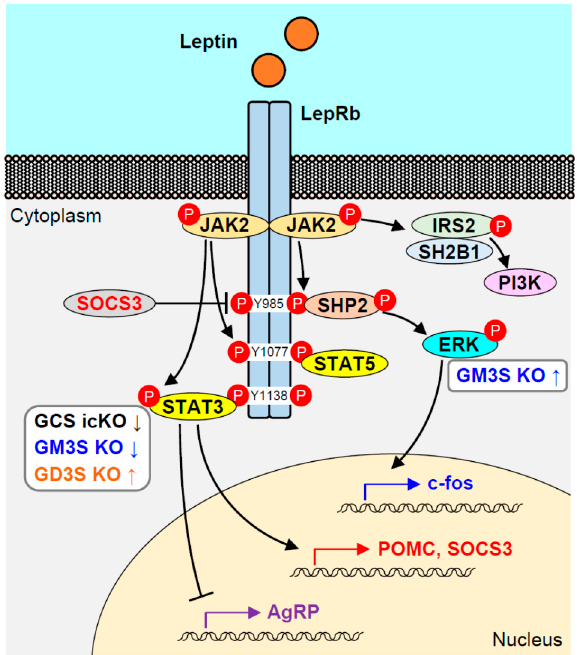
Figure 2. Leptin receptor signaling pathway, and alterations in signaling that characterize various ganglioside-deficient KO mouse models. Up and down arrows indicate increased or decreased activation of STAT3 or ERK in the pathways for the models. GCS icKO: tamoxifen-inducible, neuron-specific, conditional GCS KO.